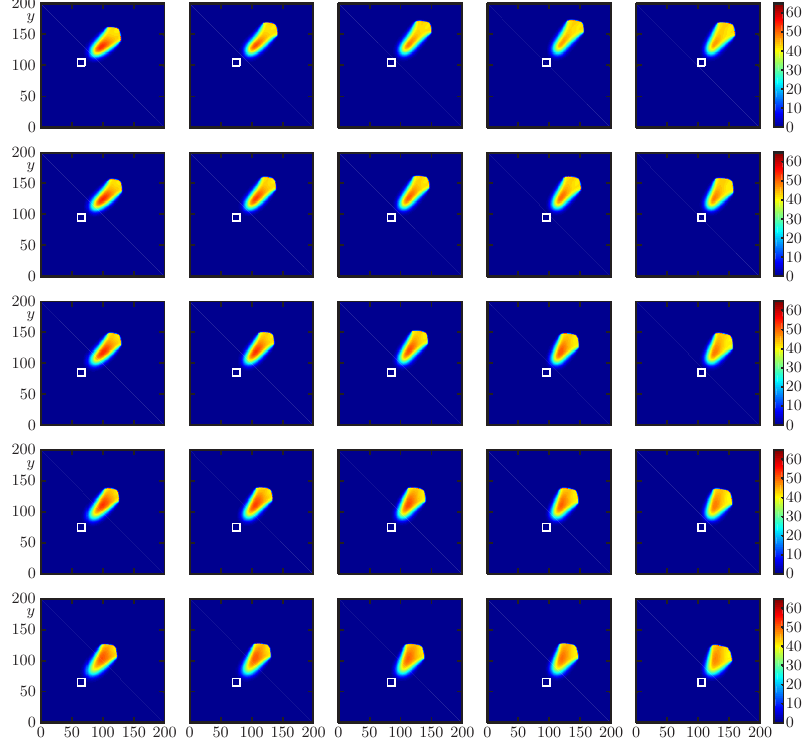
5 = 25 initial fire foci, marked by × . T 2